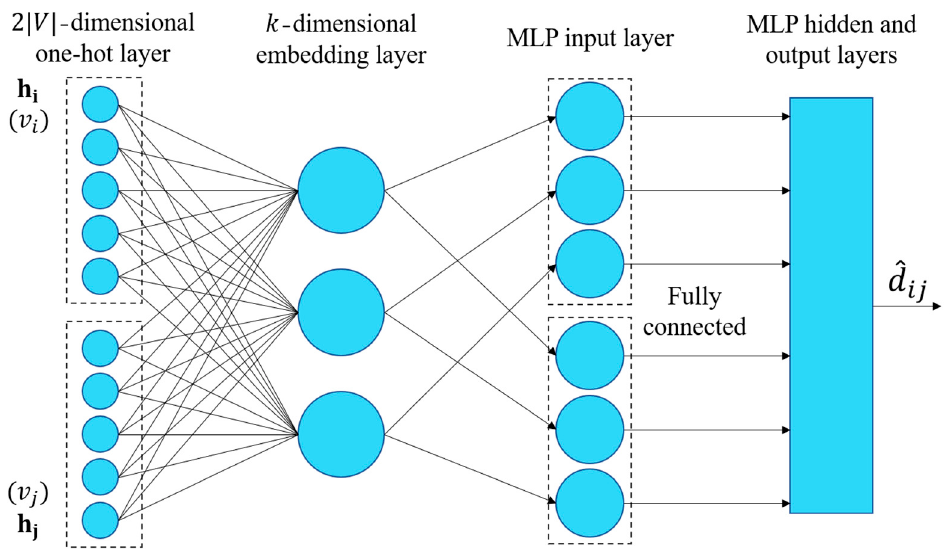
Figure 3. Base architecture of